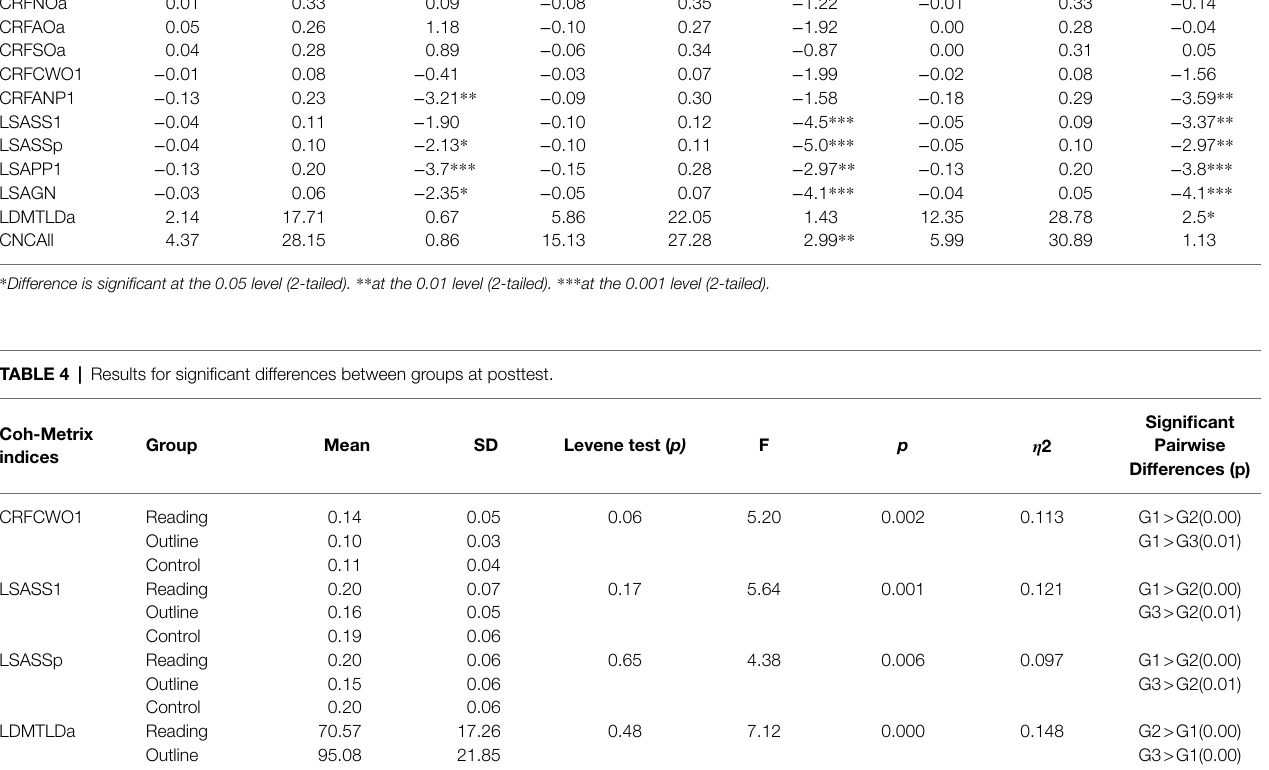
Table 4 , the reading group’s posttest essays are more lexically